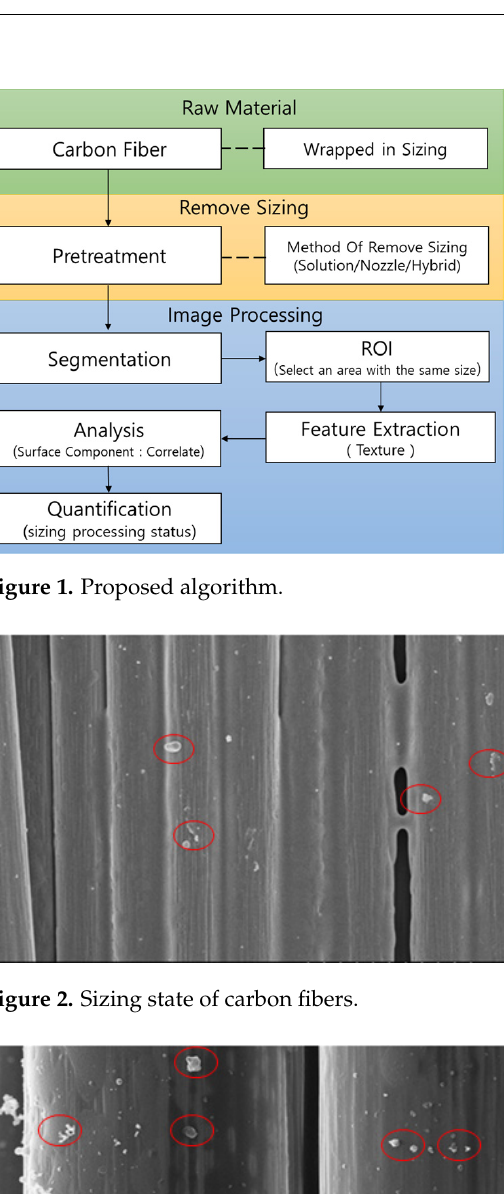
Figure 2. Sizing state of carbon fibers.